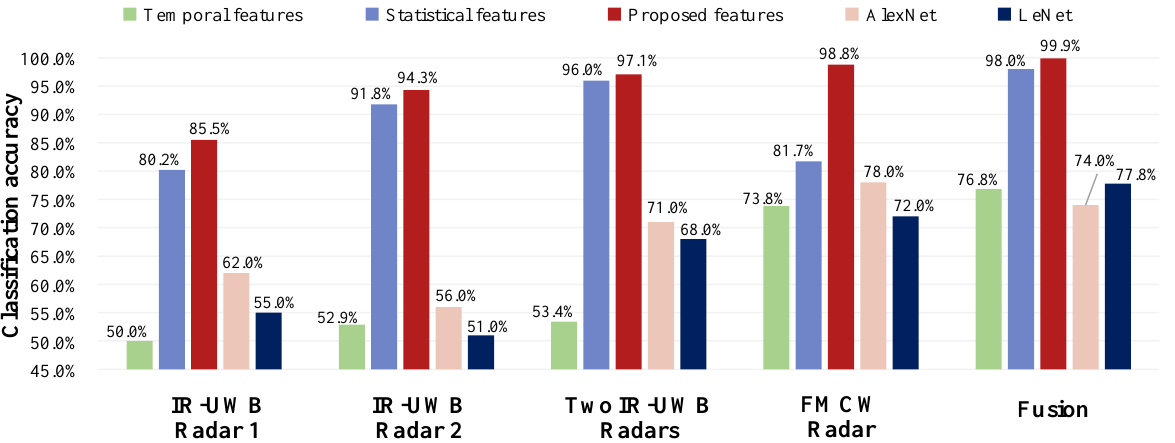
Figure 8. Classification performance comparison of different methods for activity